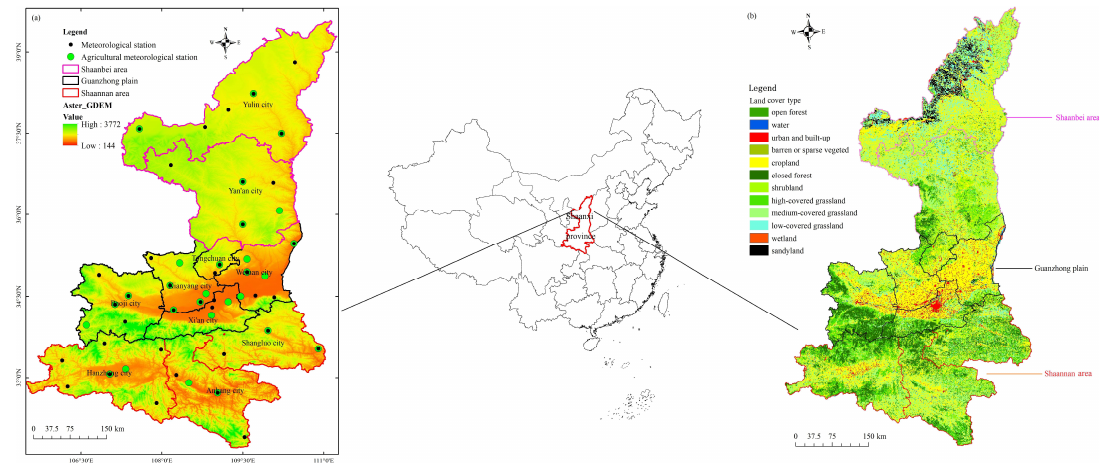
Figure 1. The study area. ( a ) Location of Shaanxi province in China and ( b ) the land cover types of Shaanxi province (https://search.earthdata.nasa.gov/).